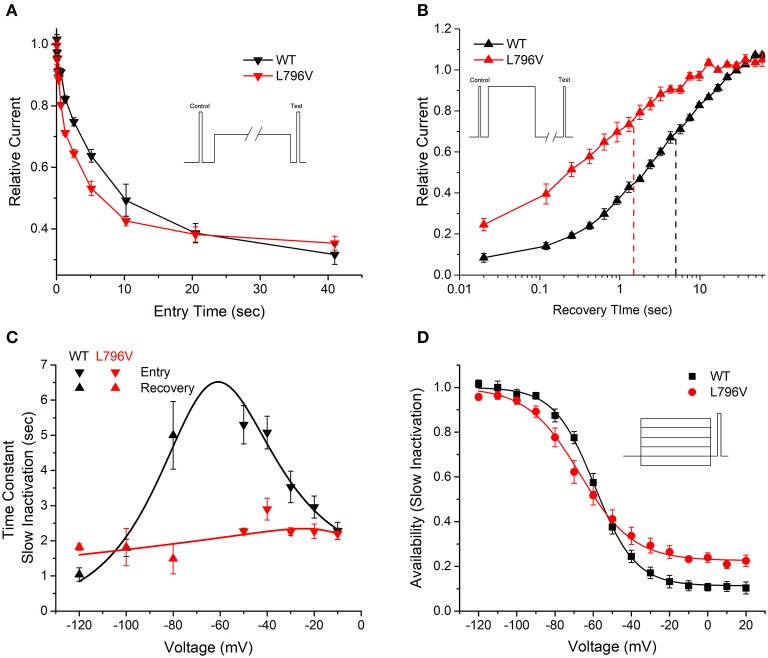
Slow inactivation is altered by the L796V mutation. (A) A two-pulse protocol with a variable duration condition pulse to −50 mV (inset) shows accelerated onset of slow inactivation for L796V channels. Symbols show means for WT (n = 5) and L796V (n = 3) channels. (B) Recovery from slow inactivation at −80 mV is accelerated four-fold for L796V compared to WT channels. Channels were slow inactivated with a 30 s conditioning pulse to −10 mV (inset), and then recovery from slow inactivation was measured as the relative peak current elicited by a brief pulse to −10 mV, after variable period of recovery at −80 mV. Symbols show means for WT (n = 5) and L796V (n = 4). (C) Summary plot for the kinetics of slow inactivation entry and recovery shows a nearly voltage-independent time constant for L796V mutant channels. Symbols show means for WT (n = 5) and L796V (n = 4) channels. (D) Steady-state voltage dependence of slow inactivation shows a decreased slope (−100 to −40 mV range) and less complete slow inactivation (higher plateau at –20 to +20 mV) for L796V (n = 5) compared to WT (n = 5) channels.